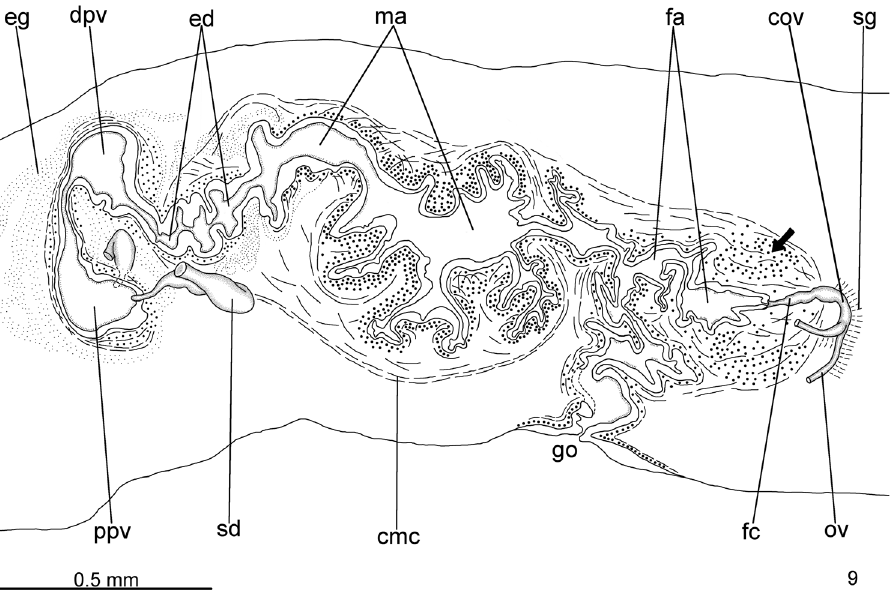
Figure 9. Pasipha ferrariaphila sp. n., holotype, sagittal composite reconstruction of copulatory apparatus. The arrow indicates the strong musculature in female atrium. Anterior to the